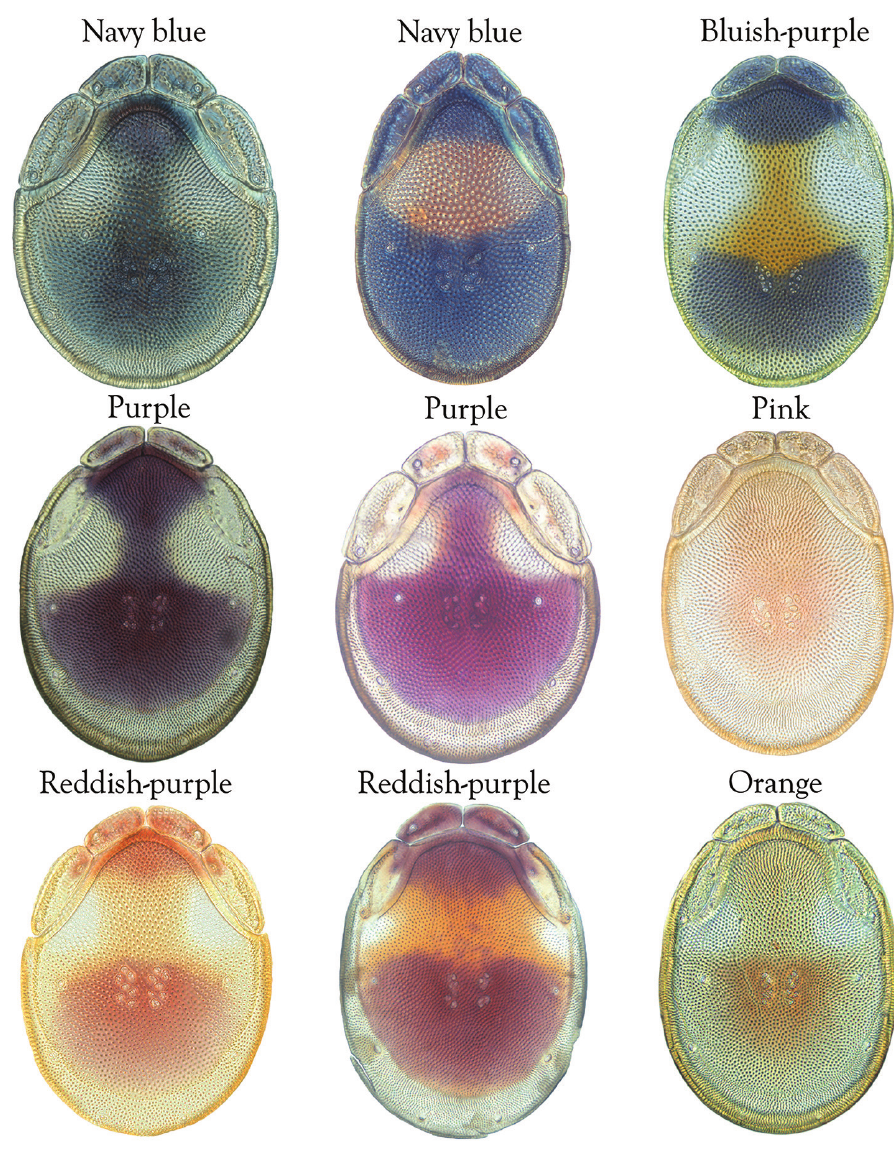
Figure 3. Terminology for coloration: blue – bluish-purple – purple-pink – reddish-purple – orange. Species depicted from top-left to bottom-right: T. gorti ; T. erectirostra ; T. biscutella ; T. neoanomala ; T. ni- groalba ; T. gorti ; T. skvarlai ; T. magnexa , and T. delicatexa .